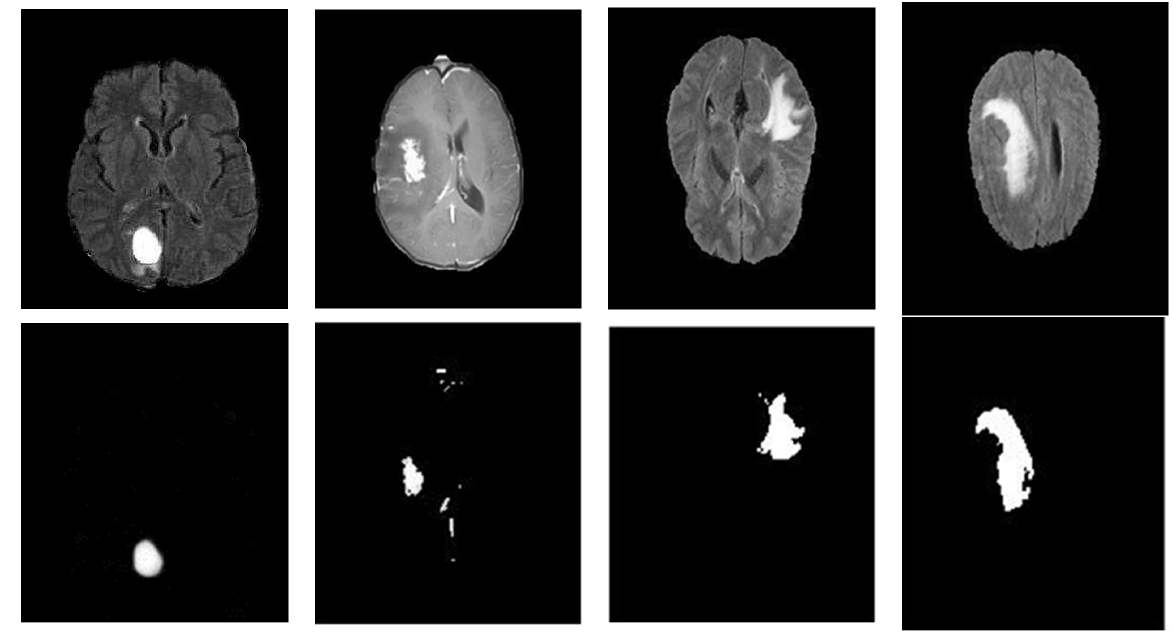
Figure 17. The efficiency of our proposed brain tumor segmentation method on the BraTS 2015